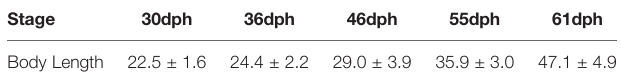
TABLE 1 | Sampling body length data of juvenile of the yellow drum (mm).